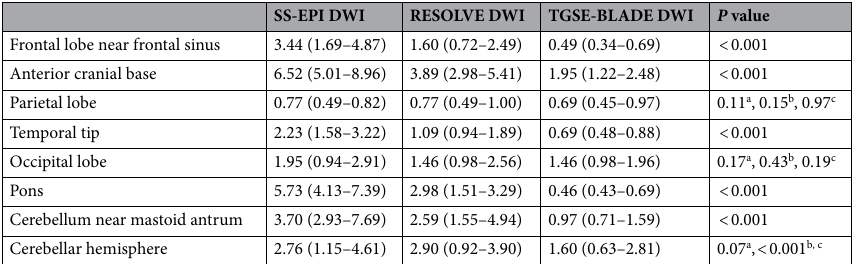
Table 3. Comparison of the length of distortion (mm) among the three DWIs in healthy volunteers. Data are presented as the median (interquartile range) (mm). a SS-EPI DWI versus RESOLVE DWI; b RESOLVE